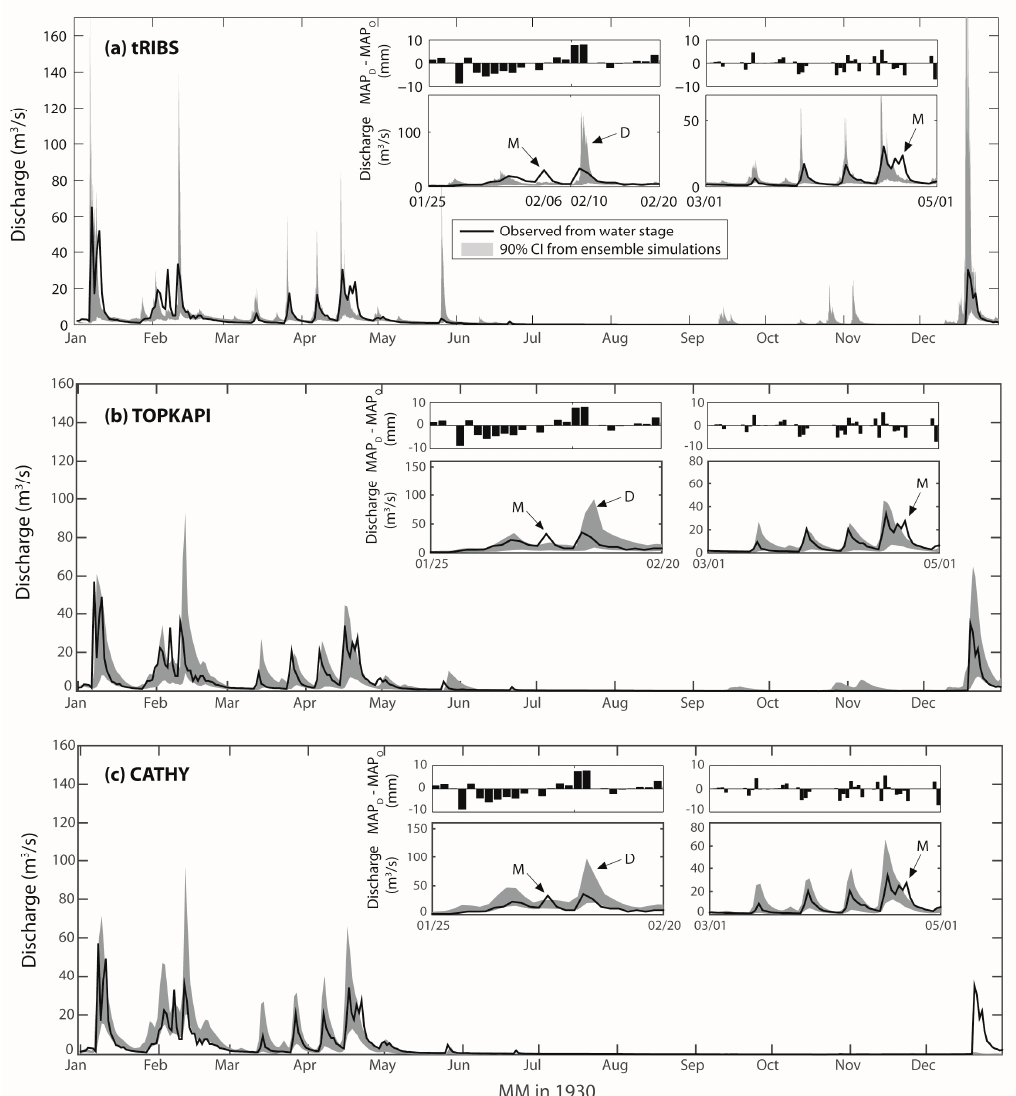
Figure 4. Simulations for the TIN-based Real-time Integrated Basin Simulator (tRIBS) ( a ), TOPographic Kinematic Approximation and Integration (TOPKAPI) ( b ), and CATchment HYdrology (CATHY) ( c ) hydrologic models applied to the Rio Mannu catchment for the 1930 period (calibration period for tRIBS). Observed discharge is compared against 90% confidence intervals (CI) derived from 50 ensemble simulations for each of the models. In the insets, a zoom on two periods with significant flood events is shown in order to better highlight the di ff erences between the daily downscaled ensemble average (MAP D ) and observed (MAP O ) mean areal precipitation time series. The peaks missed or delayed are labeled as M and D,